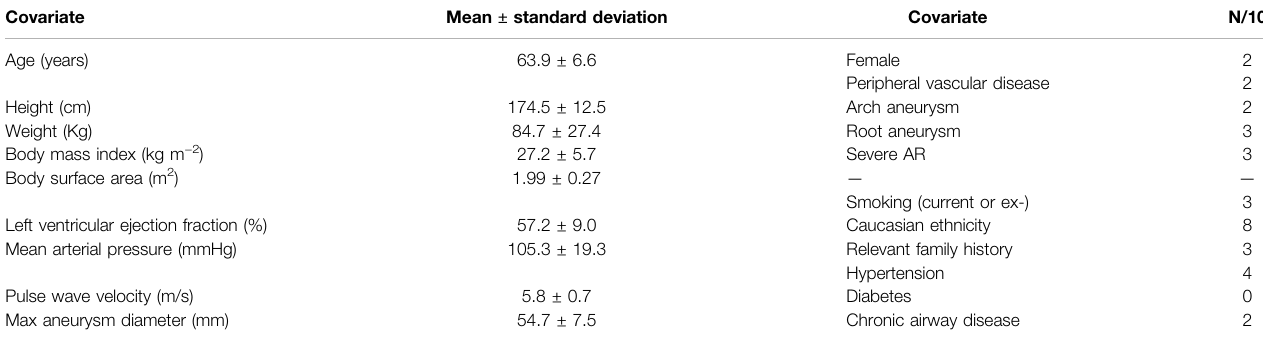
TABLE 2 | Summary of clinical covariates for recruited patients. AR (cid:1) aortic regurgitation.